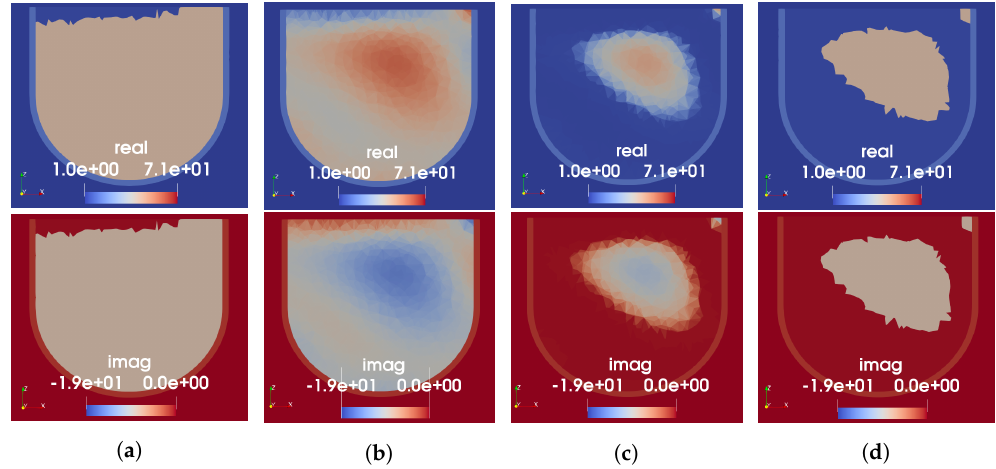
Figure 7. US-derived permittivity maps for Phantom 2. Each column shows the real (top) and imaginary (bottom) parts of relative permittivity. ( a ) Segmented mapping. ( b ) Linear mapping. ( c ) Tissue-range mapping. ( d ) Segmented mapping with low-speed values